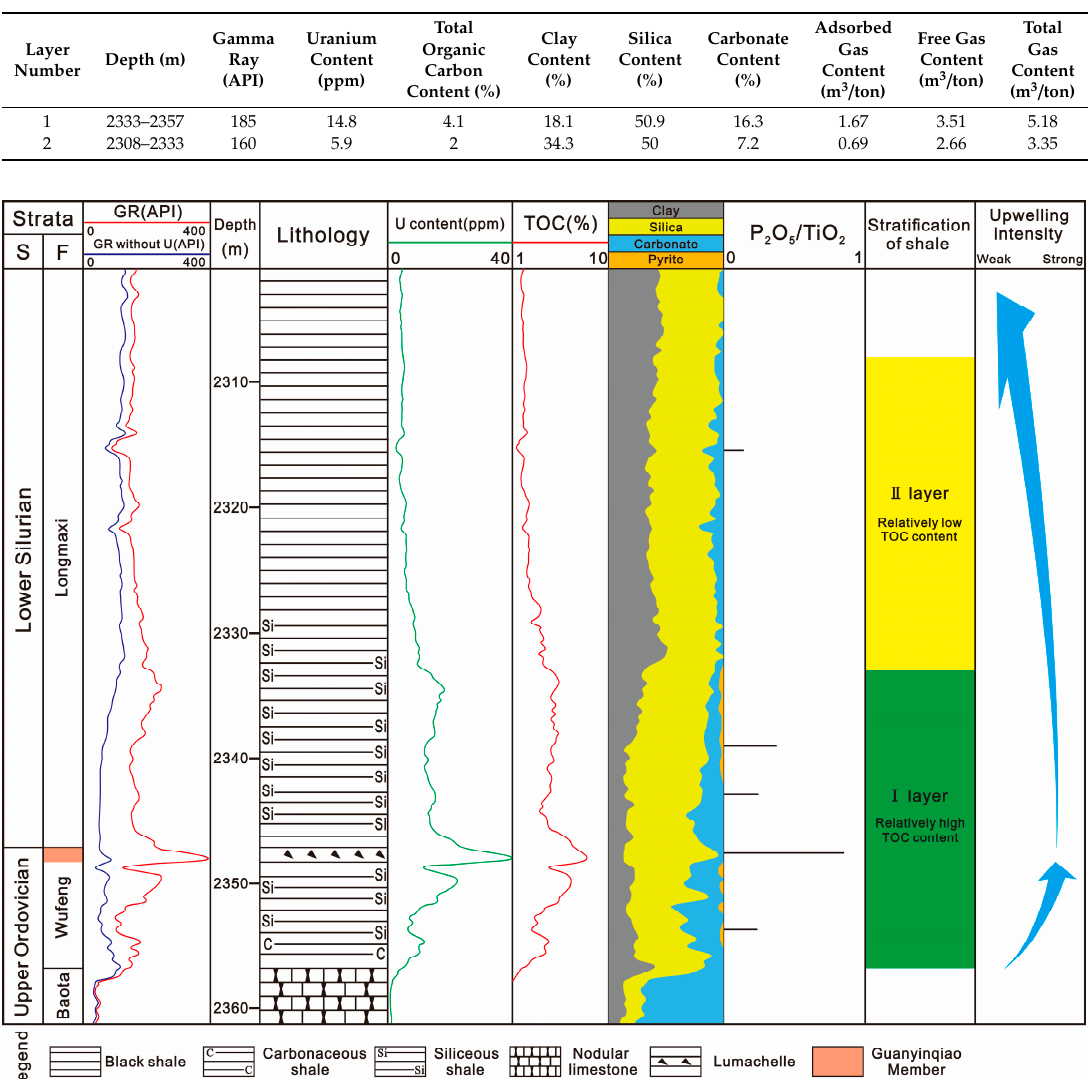
Table 1. Well N211 logging data.